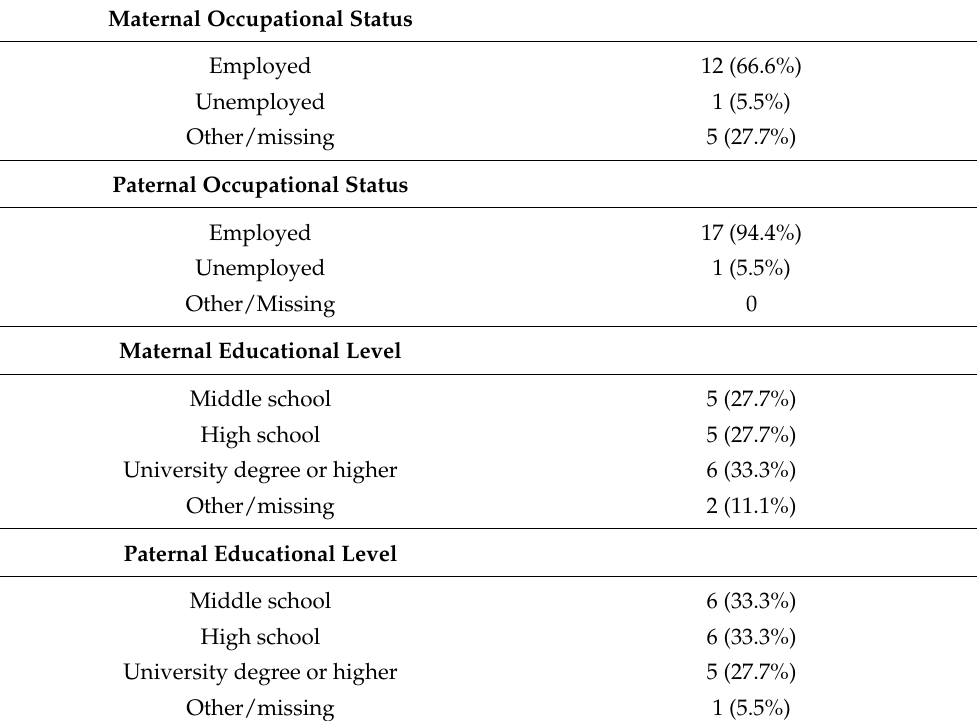
Table 2. Parents’ occupational status and educational